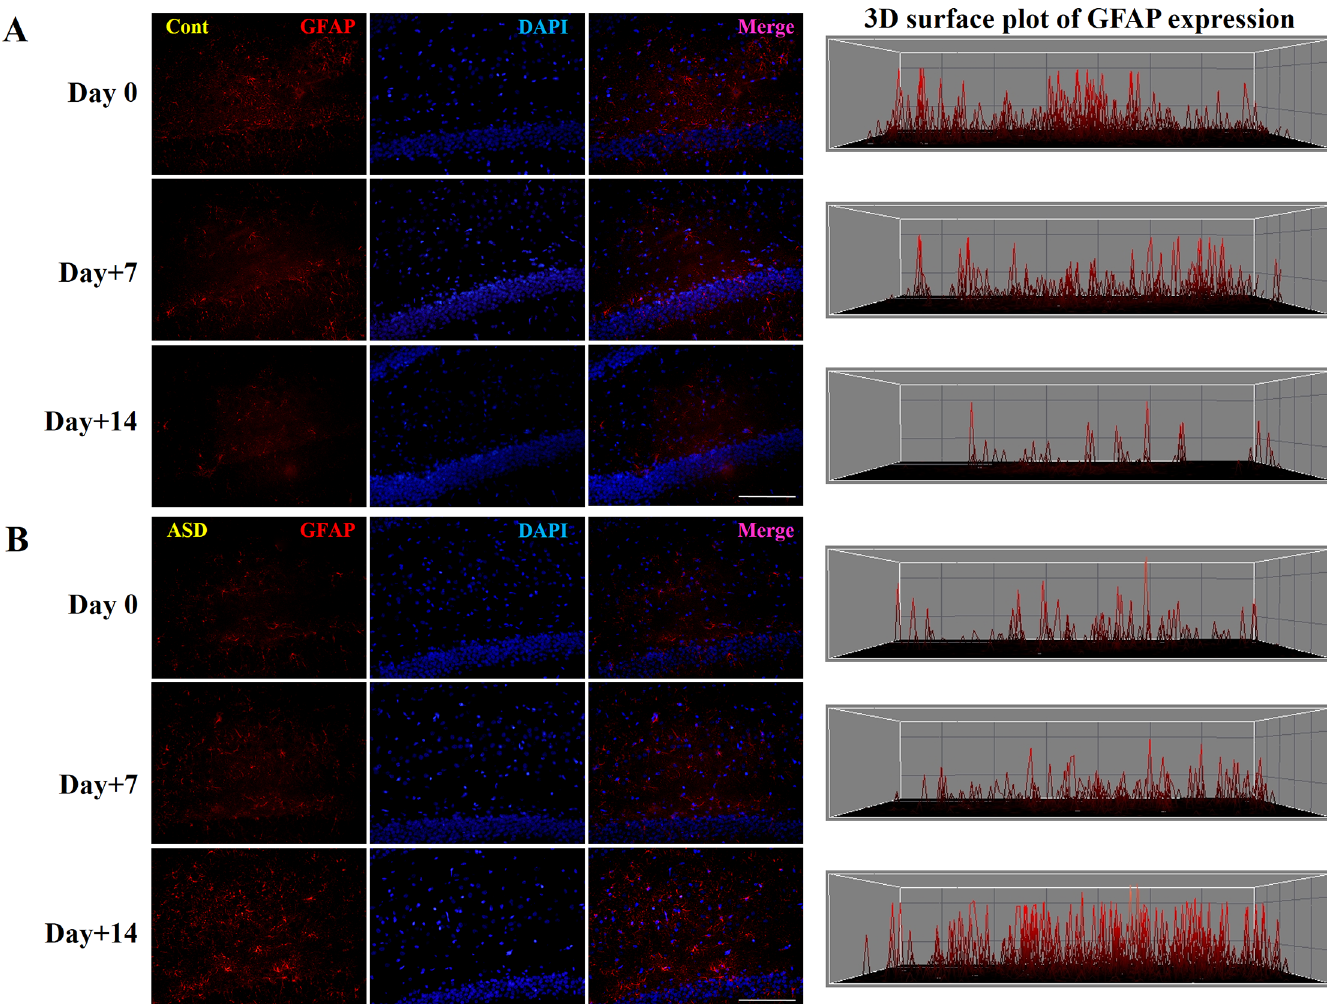
Fig 7. Immunostaining of hippocampal tissue with GFAP following PPA administration during early and late post-induction day. GFAP-positive cells (red) in the hippocampus in control (A) and PPA-treated (B) rats. To quantify the number of GFAP-positive cells, we obtained a 3D surface plot using Image-Pro Plus software. Cont, control rats; ASD, PPA-treated rats. Scale bar = 200 μ m, p < 0.01: vs . Cont.